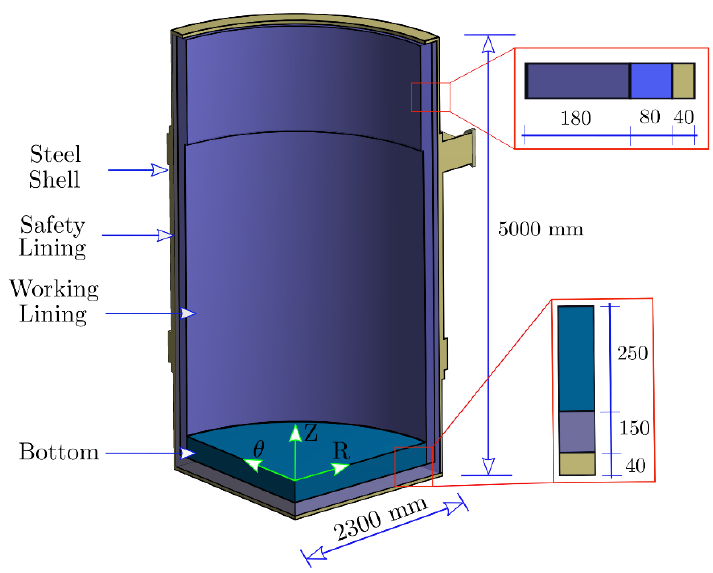
ff erent zones and